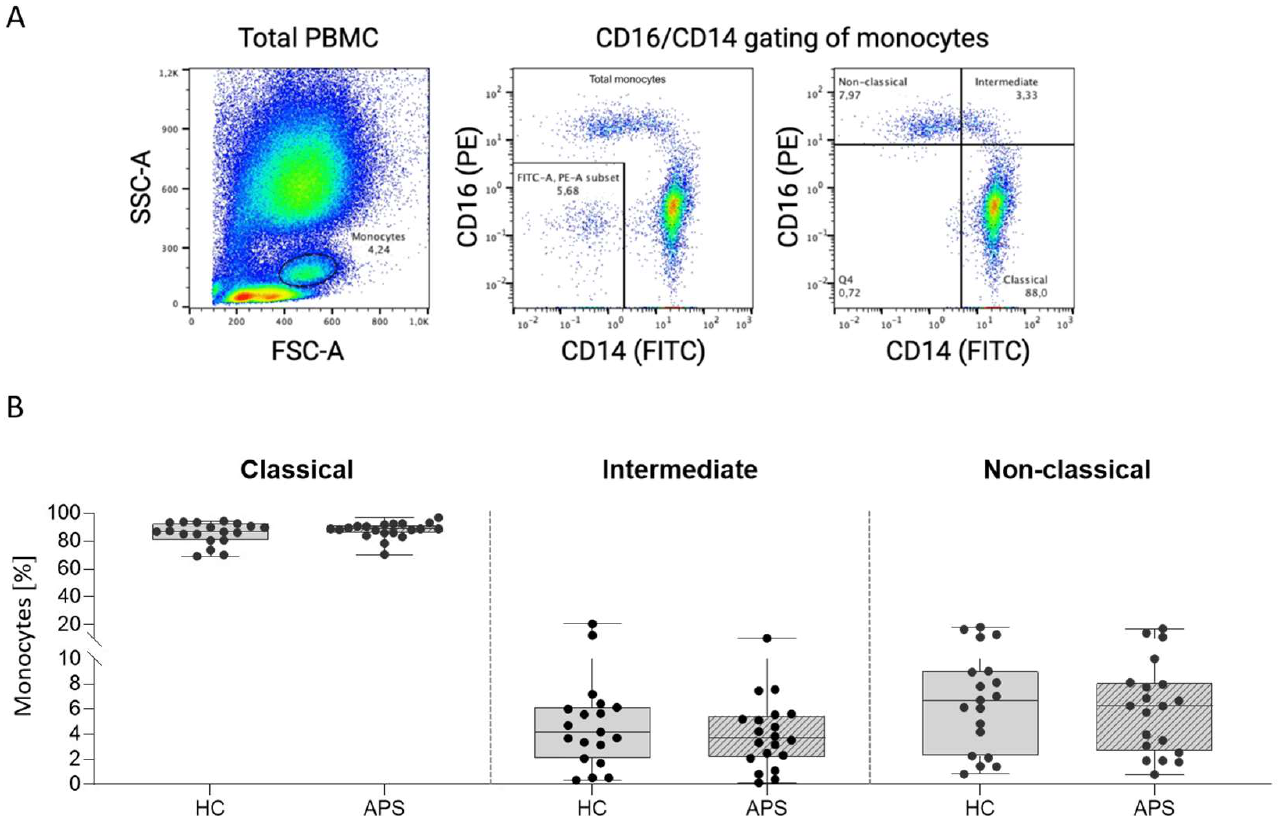
Figure 3. Identification of blood monocyte subsets by flow cytometry. ( A ) Gating strategy for identification of monocyte subsets in whole blood based on conventional bivariate scatterplots of CD16 vs. CD14. ( B ) Distribution of monocyte subsets between APS patients and HC. APS, antiphospholipid syndrome; FITC, fluorescein isothiocyanate; FSC, forward scatter; HC, healthy control; PBMC, peripheral blood mononuclear cells; PE, R-phycoerythrin; SSC, side scatter. Both total monocytes and each specific subset were analysed for a positive signal for different integrins (LFA1, MAC1, and VLA4), L-selectin, and a PSGL1 (Table 2). We demonstrated that all adhesion molecules were present on the surface of monocytes and monocyte subsets. Surface expression of VLA4 was significantly increased (median percent positive (IQR)) on classical monocyte subset in APS patients 38.6 (31.2) compared with HC 23.0 (14); p = 0.038 and on intermediate subset in APS 84.1 (28.4) compared with HC 64.2 (30.4); p = 0.038 (Table 2). Similarly, the median fluorescence intensity (MFI) of VLA4 was also significantly increased on classical and intermediate monocytes in APS patients compared with the HC. The surface expression of LFA1, L-selectin, MAC1, and PSGL1 did not differ significantly between APS patients and HC (Table